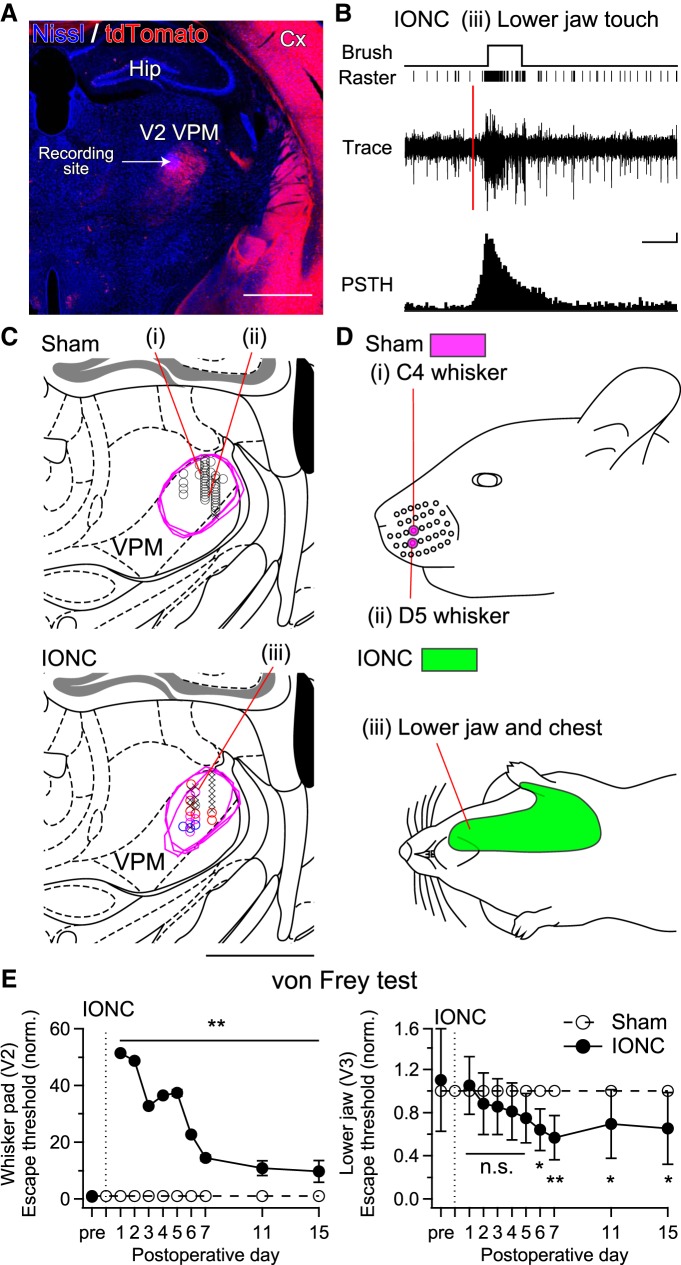
IONC induced ectopic receptive fields of V2 VPM neurons and mechanical hypersensitivities on mandibular region of face. A, C, Recording sites located by electrical lesion made after receptive field recordings. Only recordings in the V2 VPM characterized by dense tdTomato-labeled lemniscal fiber terminals were analyzed. A representative image is shown (A), and all recording sites analyzed were reconstructed on the brain atlas of Franklin and Paxinos (2008) (C). Black circles = recording sites of maxillary receptive fields only; blue circles = recording sites of mandibular receptive fields; red circles = recording sites of nontrigeminal receptive fields; Magenta circles = recording sites of both mandibular and nontrigeminal receptive fields; multiplication signs = nonresponsive sites. Magenta brackets indicate the manually traced V2 VPM regions. Roman numerals indicate recording sites of representative recordings shown in B and D. Scale bars, 1 mm. Cx, cerebral cortex; Hip, hippocampus; VPM, ventral posteromedial thalamic nucleus. B, Representative recording of IONC-operated mouse at the recording site (iii). Red vertical line indicates the timing of cue for stimulation. Time scale, 250 ms; Scale for peristimulus time histogram, 10 spikes. D, Representative receptive fields of V2 VPM neurons. Each Roman numeral corresponds to the recording from the site indicated in C. Colored areas on the age-matched mouse traces indicate receptive fields at the recording sites. Magenta = sham; green = IONC. Body surface at which there is stimulus-locked significant increase in firing rate from basal firing is considered as the receptive field. E, Face-escape thresholds assessed by von Frey filament stimuli on whisker pad and lower jaw before and 1–15 d after IONC operation on P21. Each value was normalized to that of sham group. Twelve mice for each group were examined. Values are represented as mean ± SD. Statistical significance was tested by two-way repeated ANOVA and post hoc Tukey HSD test. *p < 0.05; **p < 0.01; n.s., not significant; two-tailed.